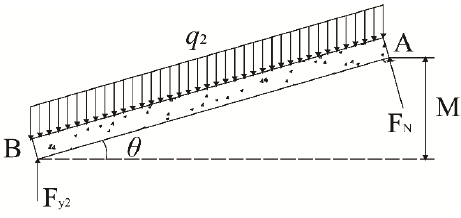
Figure 8. Support structure of KS1.